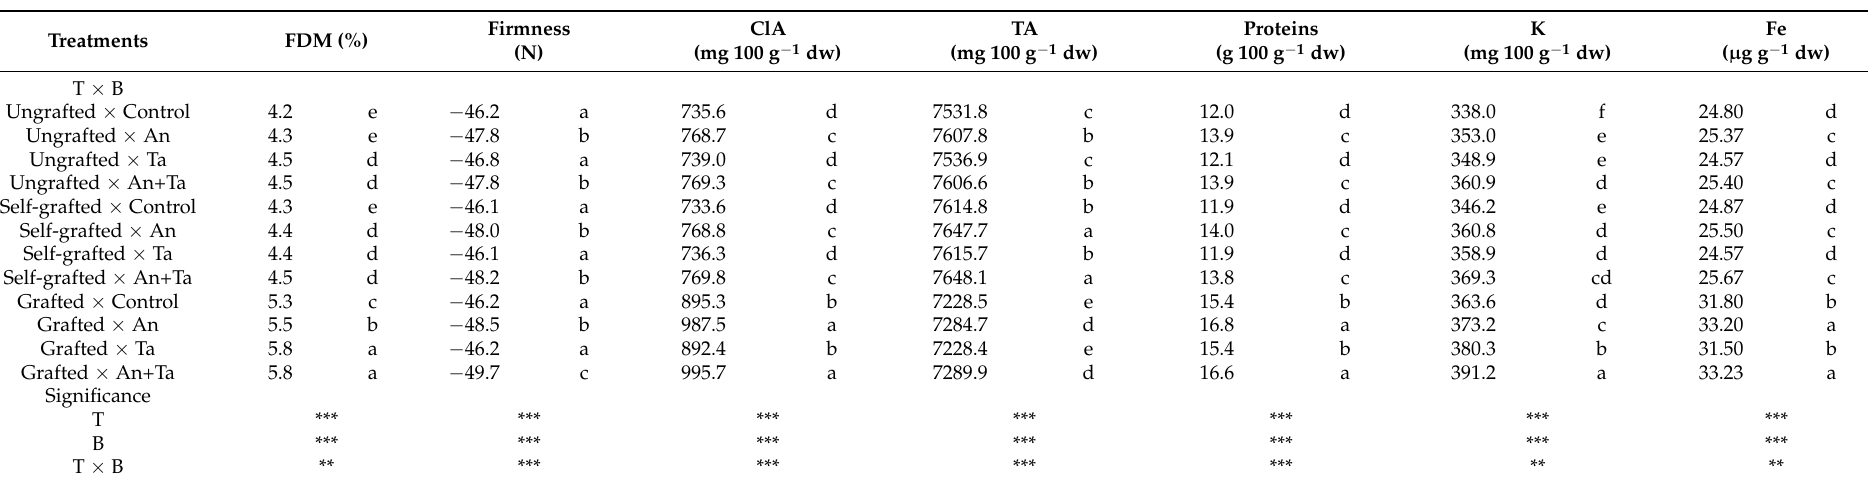
Table 1. Effect of plant type (T) and biostimulant (B) on fruit dry matter (FDM), fruit firmness, total anthocianins (TA), potassium (K), and iron (Fe) of ‘Birgah’ F 1 eggplant.